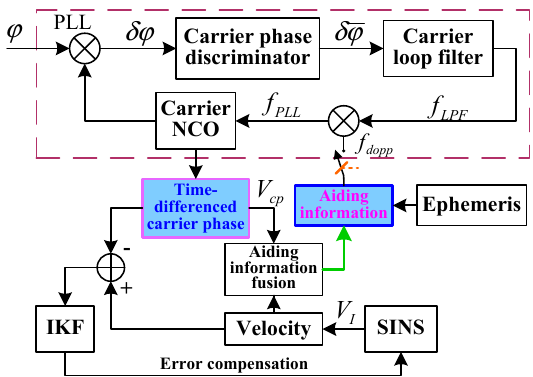
Figure 4. Configuration of TDCP velocity-assisted PLL tracking. NCO: numerically controlled oscillator; f dopp is the Doppler frequency, f LPF is output of loop filter, f PLL is Control frequency of NCO, V cp is TDCP velocity, V I is velocity of